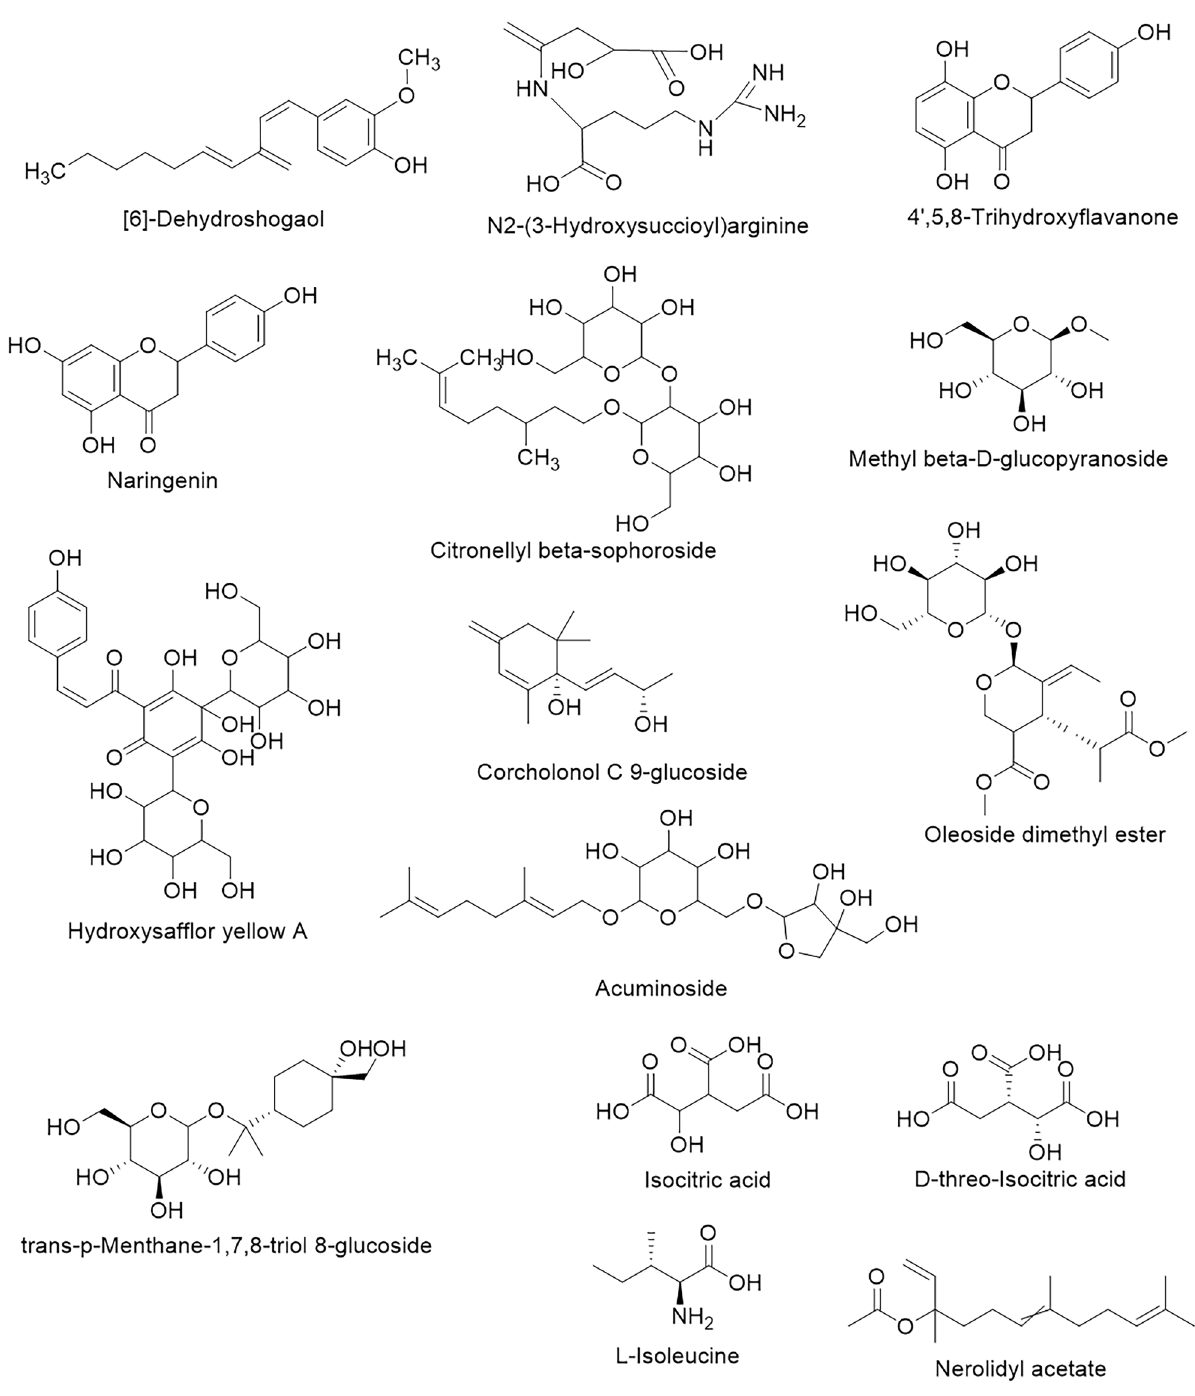
Figure 6. Chemical constructure of 15 significant increased